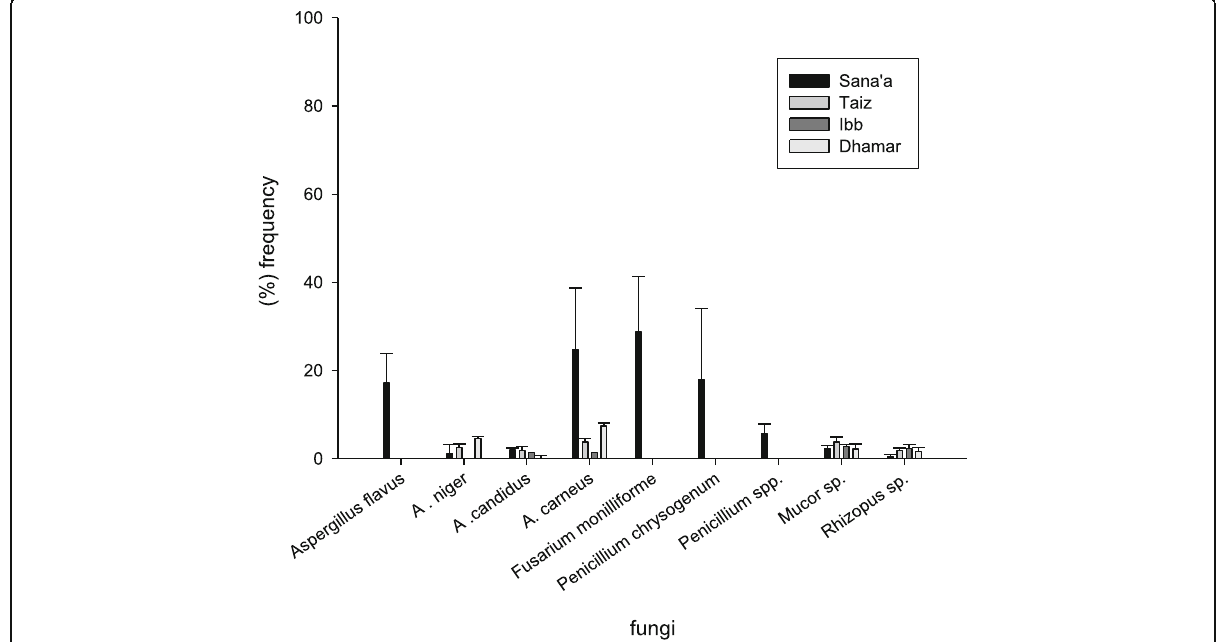
Fig. 2 Effect of locality on occurrence of fungi in samples collected from farmers in four governorates (Sana ’ a, Taiz, Ibb, and Dhamar